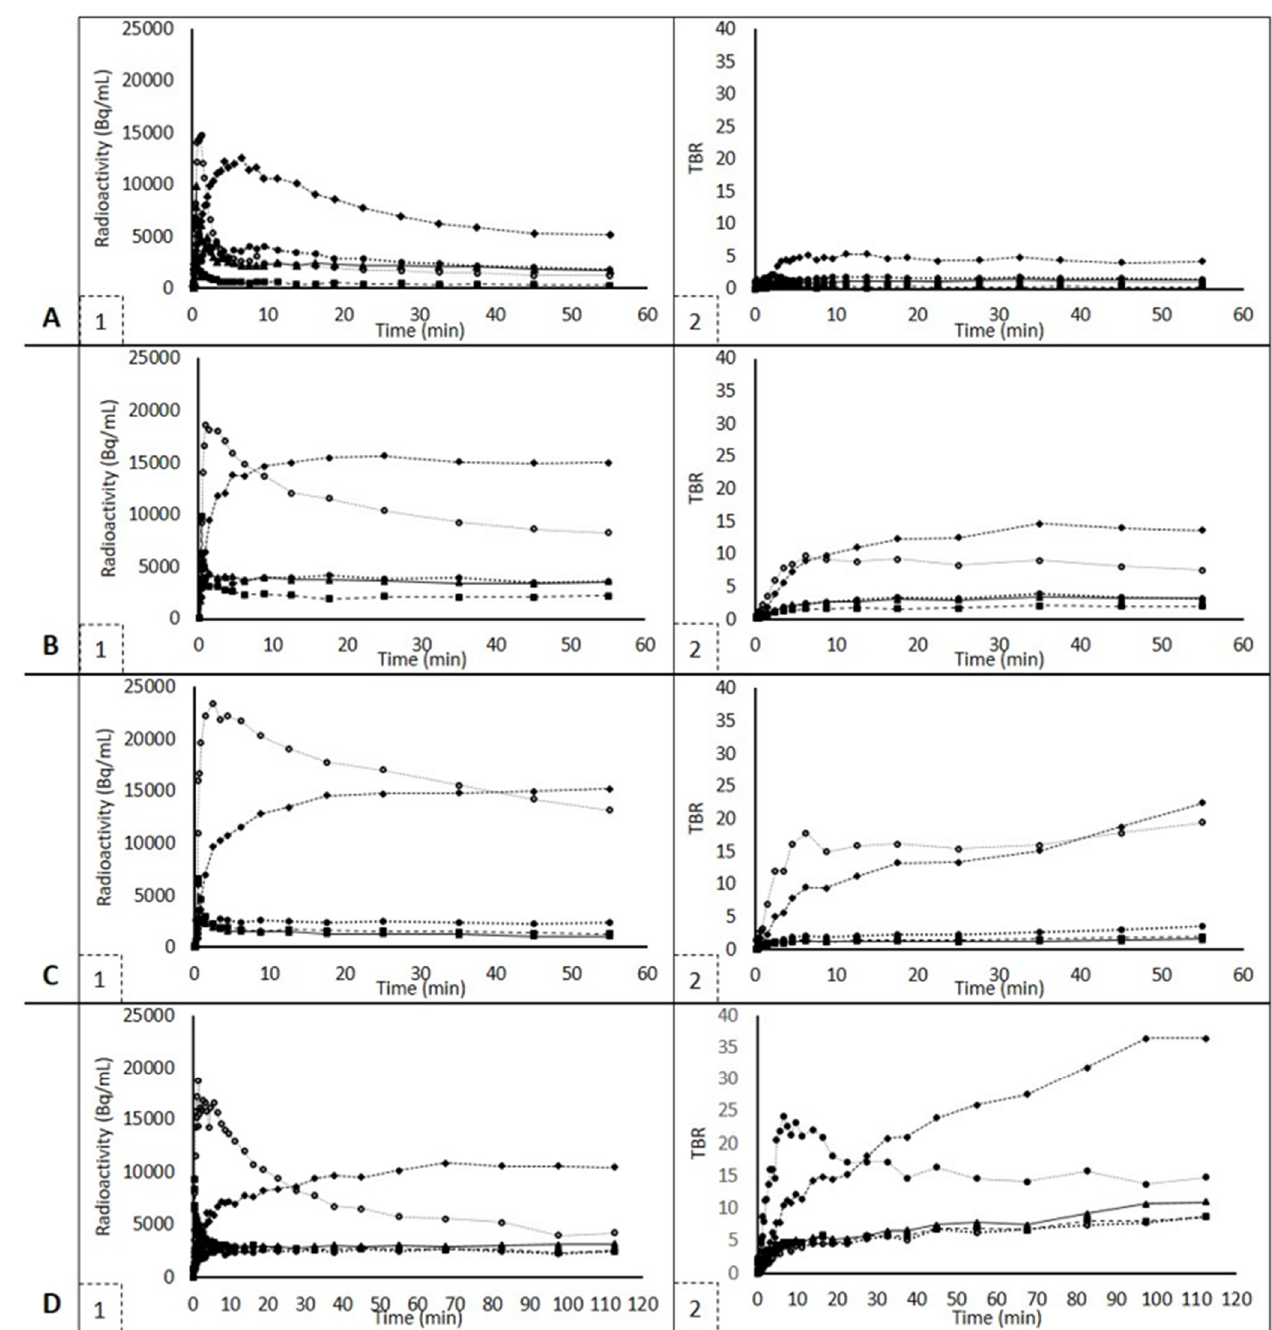
Figure 3. SUV and TBR TACs for each tracer. Figures on the left show SUV TACs, figures on the right show TBR TACs and are uniformly scaled apart from 11 C ‐ osimertinib scans, which were 120 minutes instead of 60 min. Figures A1 and A2 show 11 C ‐ erlotinib TACs. Figures B1 and B2 show 18 F ‐ afatinib TACs, EGFR mutated. Since these are typical examples, wild type 18 F ‐ afatinib TACs are shown in figure C1 and C2 . 11 C ‐ osimertinib TACs are shown in figure D1 and D2 . Squares represent lung, triangles represent tumor, diamonds represent liver, stroked circles (black line, white center) represent spleen and filled ‐ in, black circles represent vertebra.